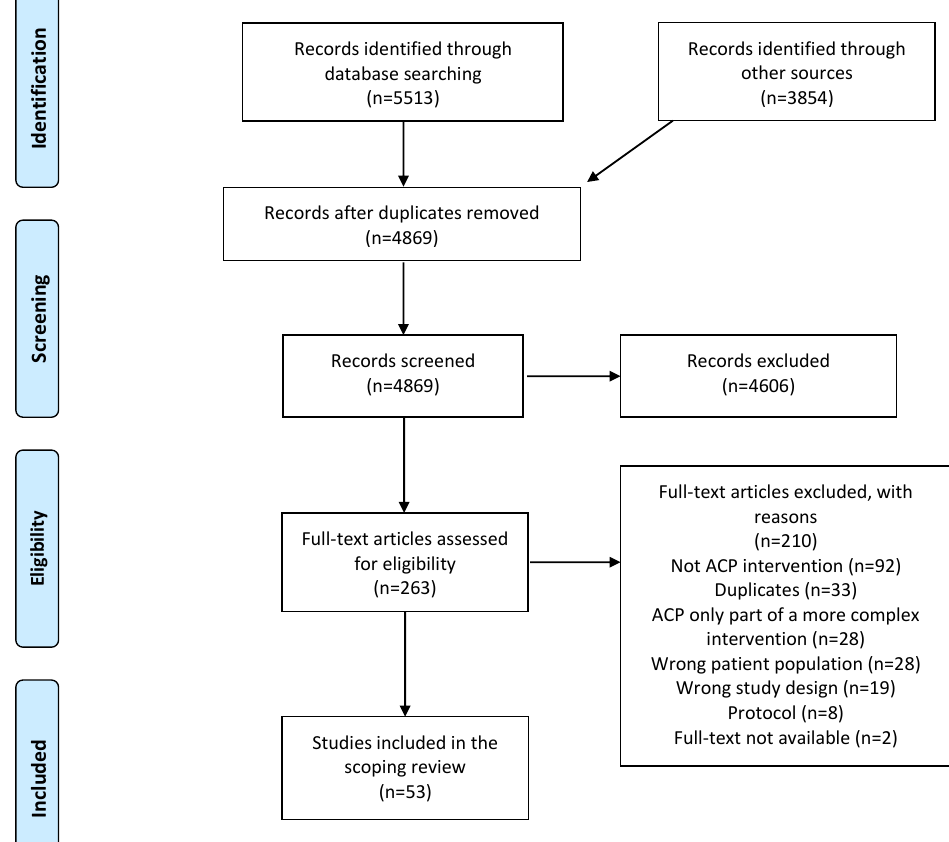
Figure 1. Study flow diagram. ACP is advance care